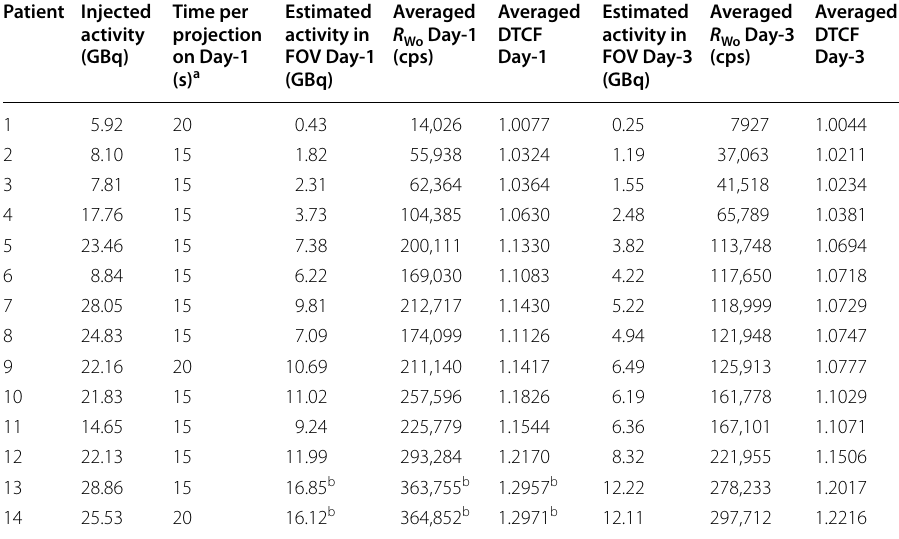
Table 2 Patients quantitative SPECT